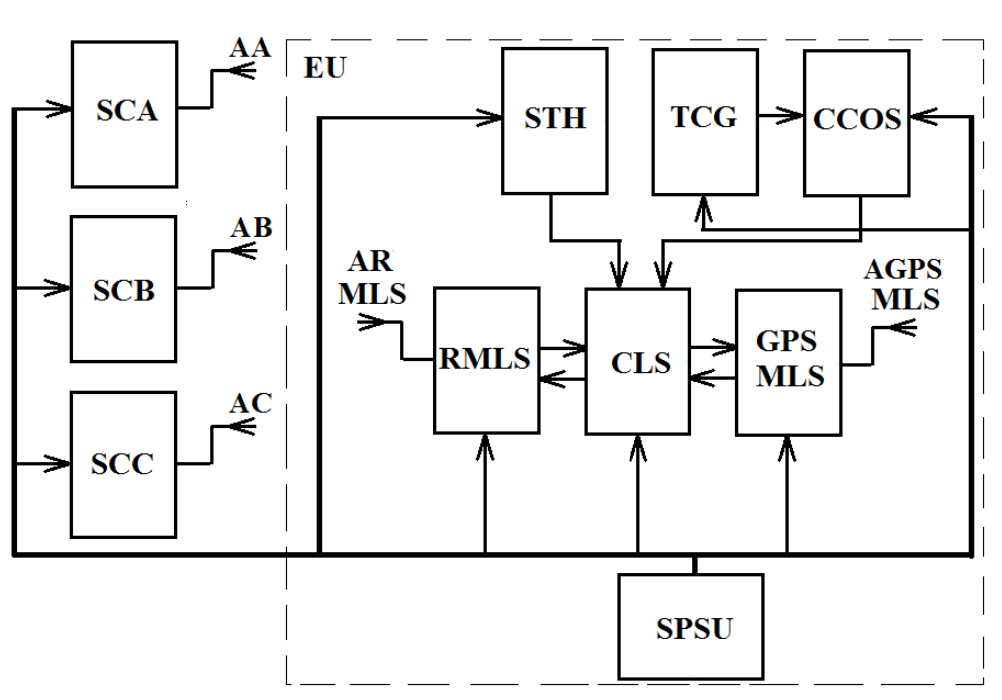
Figure 3. Structural diagram of the local